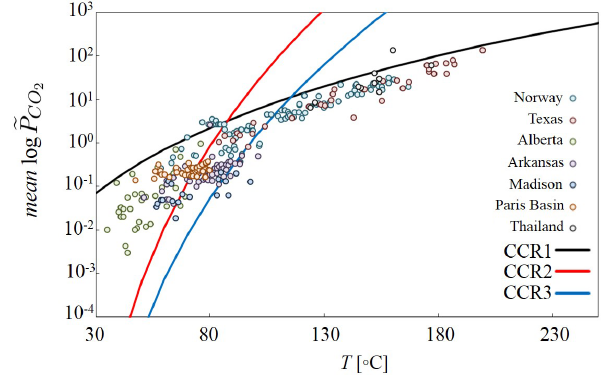
Figure 4. Evolution of the mean log (cid:101) P CO trend as a function of 2 temperature computed for CCR1, CCR2 and CCR3 assuming that P and T are described by P (bar) = 6 × ( T ( ◦ C) − 22) suggested by (suggested by Smith and Ehrenberg, 1989). As a term of com- is measured in various sedimentary basins labeled parison, P CO 2 Norway, Texas, Alberta, Arkansas, Madison, Paris Basin, and Thai- land (reported in Coudrain-Ribstein et al.,